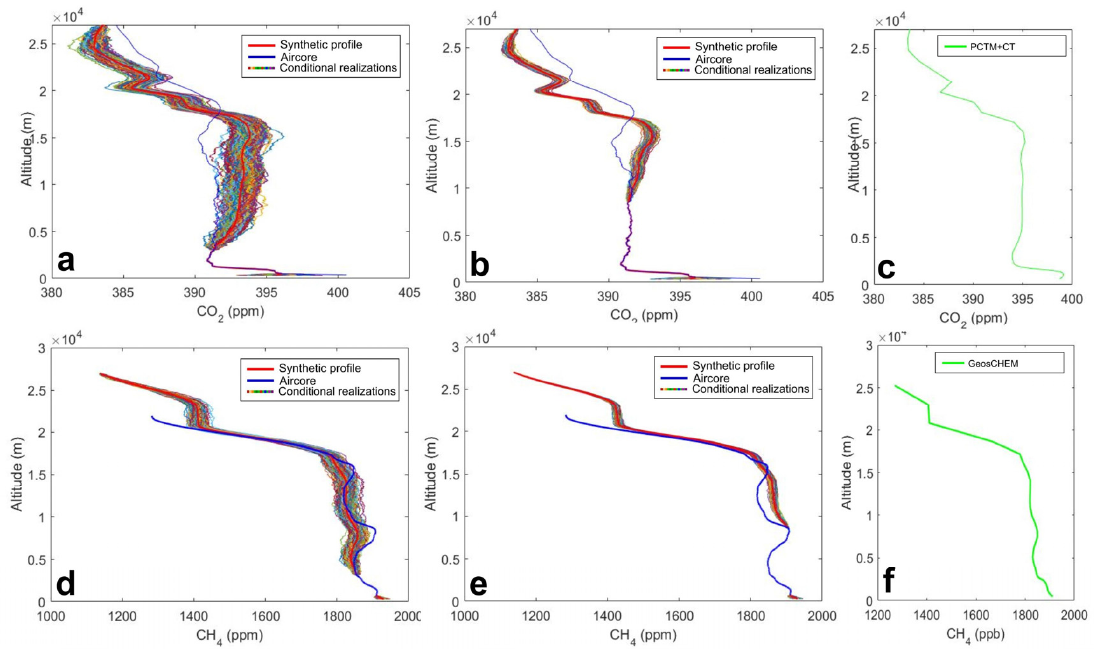
Figure 2. Sampled and reconstructed fraction of the CO 2 column (24 October 2012) ( a , b ), and CH 4 (17 September 2014) ( d , e ) showing ensemble conditional realization cloud based on the covariance parameters inferred at the top of the sampled partial column. Modeled profiles for CO 2 and CH 4 are given in ( c , f ), respectively. Red line extending from the top of the sampled fraction upward represents the synthetic profile. Simulated sampled column altitude range was: ( a ) h < 3000 m and ( b ) h < 8500 m, visible in the profiles as the altitude ranges where conditionally simulated ensembles are missing.